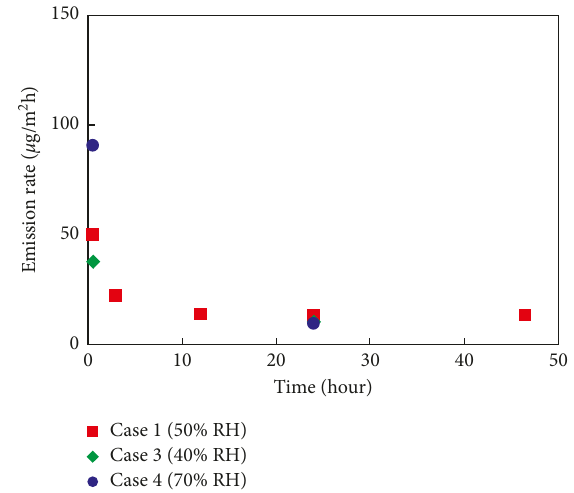
Figure 5: A plot of emission rate versus time showing the emission of DEHP from the flooring specimen with regard to relative hu- midity (RH).